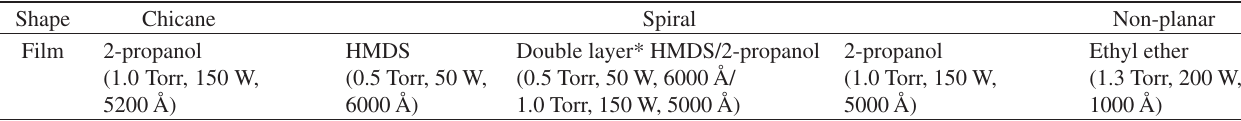
Table 1. Condition process for plasma deposition of adsorbent films on microchannels.